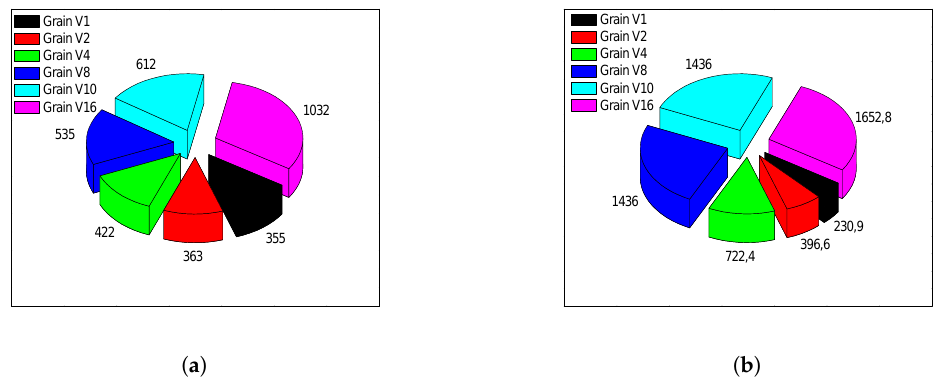
Figure 8. The Grain Performances. ( a ) Grain version area occupancy; ( b ) Grain version